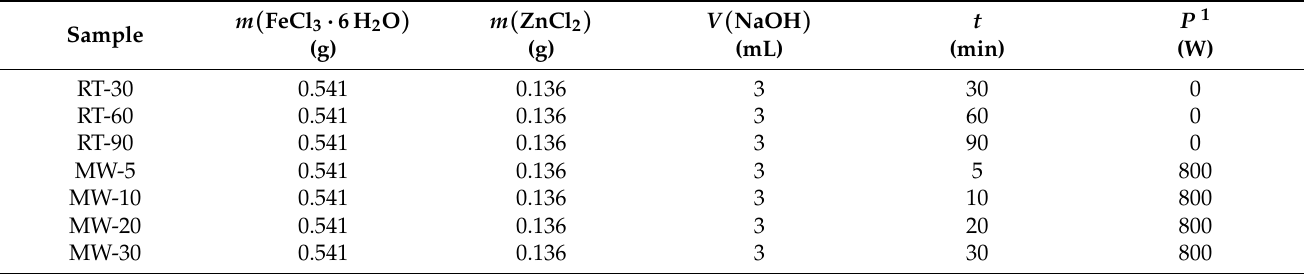
Table 1. Samples prepared in microwave oven with reflux system with applied microwave field in V ( H 2 O ) =